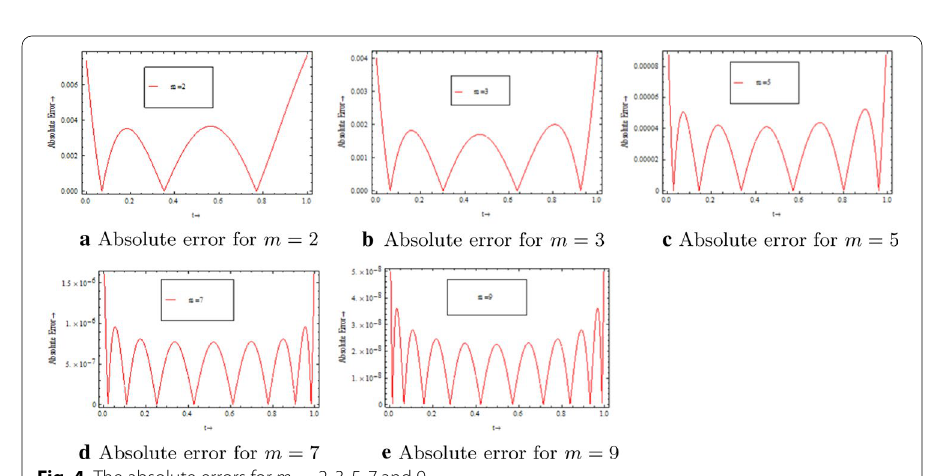
Fig. 4 The absolute errors for m = 2,3,5,7 and